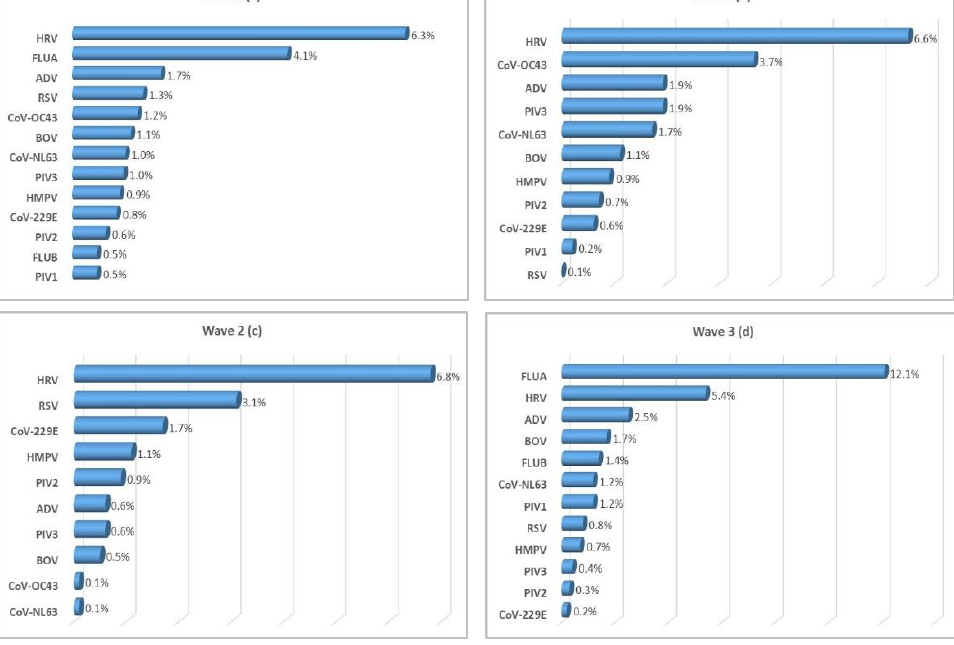
Figure 1. Proportion of viral etiologies detected in COVID-19-negative patients during the three waves ( a ) and during wave 1 ( b ), wave 2 ( c ), and wave 3 ( d ). ADV: adenovirus, BOV: bocavirus, CoV: coronavirus, FLU: influenza, HMPV: human metapneumovirus, HRV: human rhinoviruses, PIV: parainfluenza viruses, RSV: respiratory syncytial viruses.